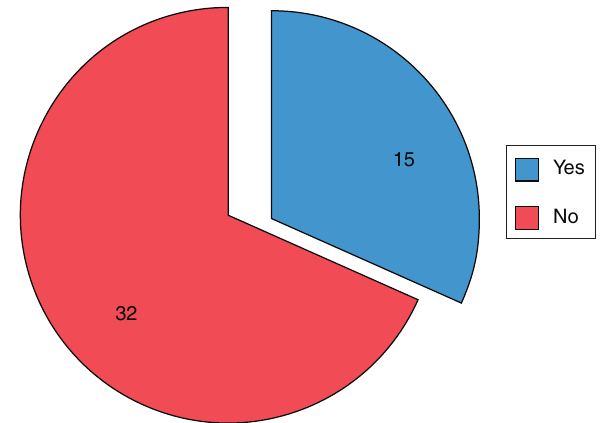
Knowledge about specific tests to assess hearing in childhood ( n =